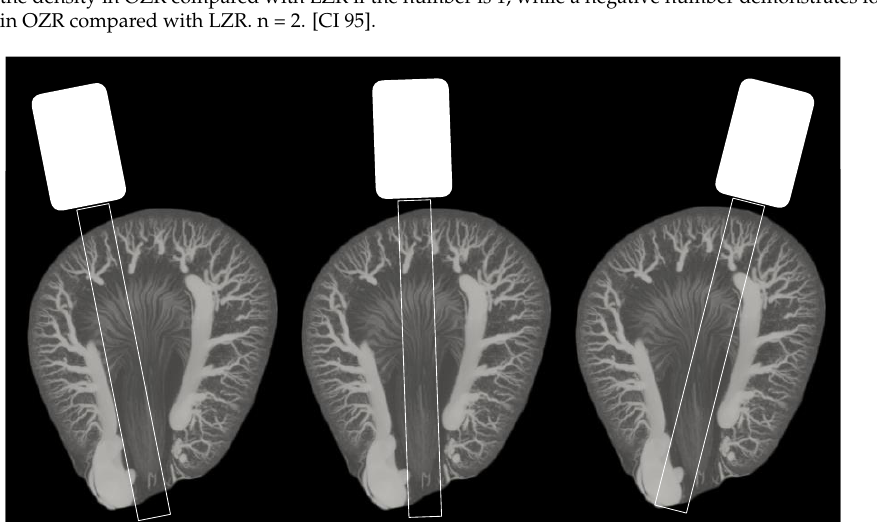
Figure 4. Illustration of three different ultrasound probe positions (coronal slice) on an axial slice maximum intensity projection (50 slices) from an ex vivo µCT of a Sprague Dawley rat kidney filled with intravascular Microfil (from a separate study). The image in the middle demonstrates the optimal position for visualization of inner and outer medulla, as the two other positions can include more of the surrounding tissue, larger vessels, and vasa recta going in the elevational direction. Comparing tortuosity in the six regions showed no noteworthy differences, as illus- trated in Table